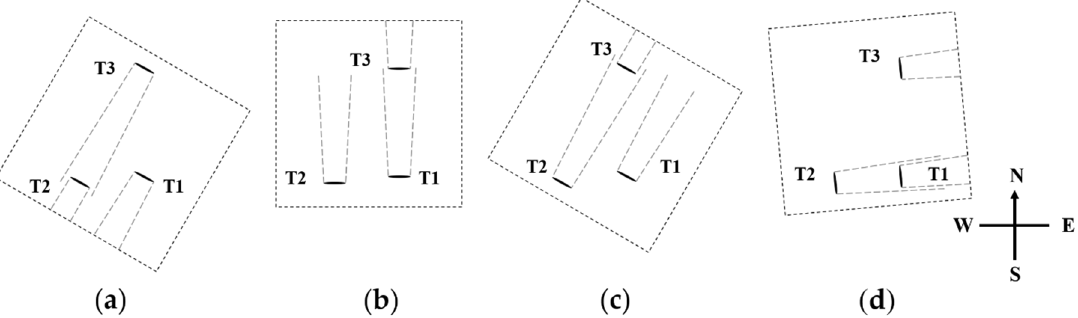
Figure 2. Diagram of wind turbine configurations in different wind directions; ( a ) north-east (150 ◦ ), ( b ) south (0 ◦ ), ( c ) south-west (330 ◦ ), and ( d ) west (274 ◦ ). Solid lines marked using T1, T2 and T3 represent the location of three turbines. Dashed lines represent the wake of each turbine.